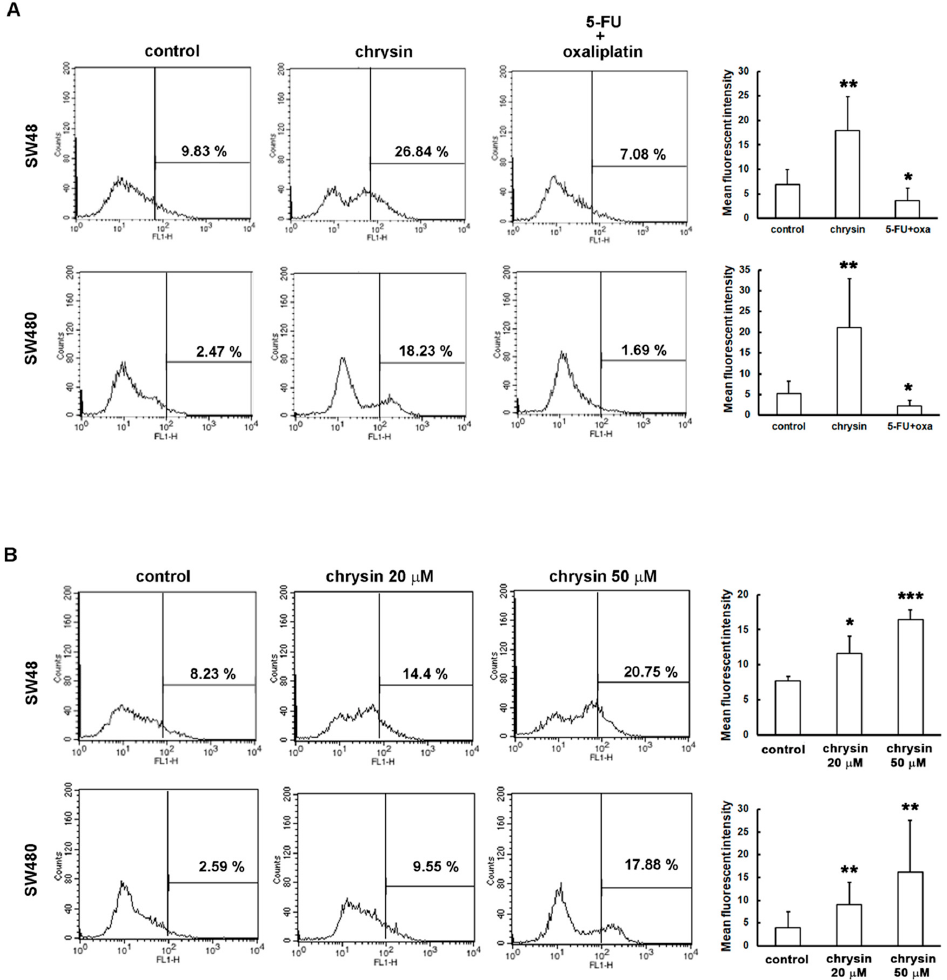
Figure 6. Chrysin, not 5-fluorouracil (5-FU)/oxaliplatin, induced the production of reactive oxygen species (ROS) in colorectal cancer (CRC) cells. ( A , B ) SW48 and SW480 cells were seeded overnight, and treated with the indicated concentrations of 50 μ M chrysin or 25 μ M 5-FU/25 μ M oxaliplatin for 24 h. Then, following trypsinization, cell pellets were stained with 10 μ M CM-H 2 DCFDA at 37 °C in the dark for 30 min. Intracellular ROS level was measured using flow cytometry, and was statistically quantified. * p < 0.05; ** p < 0.01; *** p < 0.001 when compared with indicated control groups. A p -value < 0.05 was considered as statistically significant.